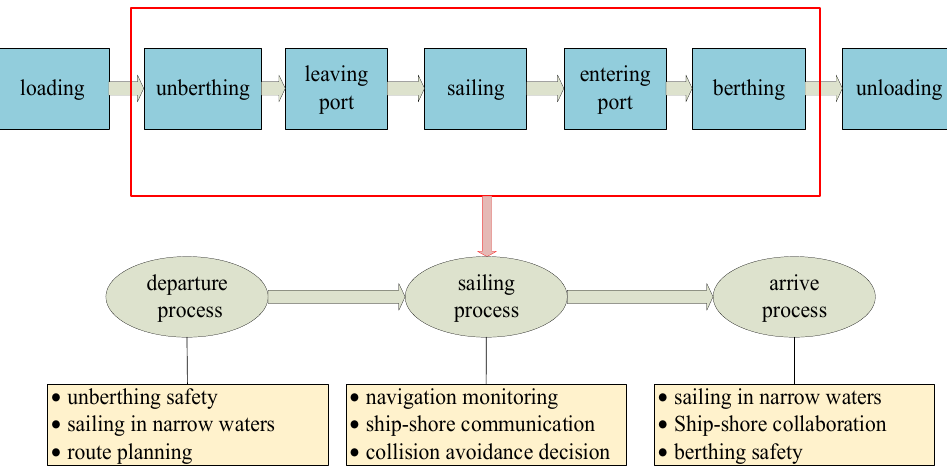
Figure 11. Scenario settings for the effectiveness evaluation of SRMS.